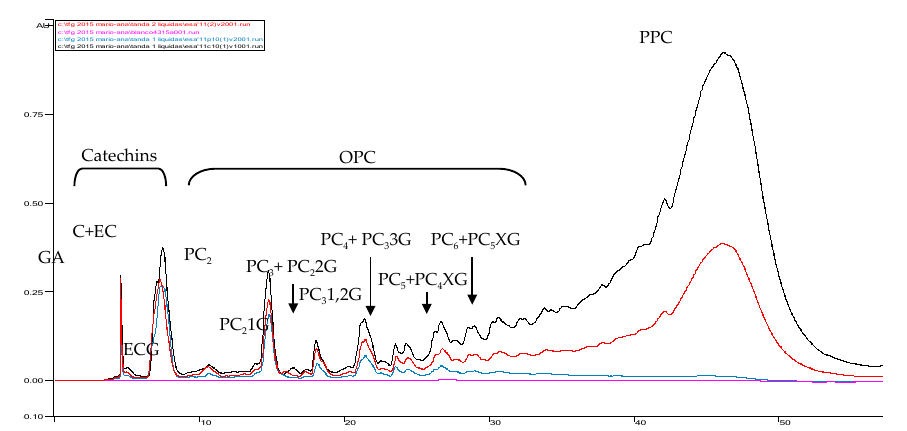
Figure 4. Overlay of NP–HPLC–PAD chromatograms (280 nm) of the initial (clarified) grape seed extract (GSE; red), the final permeate (blue), the final concentrate (black) and the HPLC baseline (violet) after GSE fractionation by a 10-kDa MMCO membrane (data refer to one replicate). GA—gallic acid, C + EC—catechin and epicatechin, ECG—epicatechin gallate, PC 2 to PC 6 —procyanidin dimers to hexamers, PC 2 1G—monogaloylated procyanidin dimer, PC 2 2G—digaloylated procyanidin dimer, PC 3 1,2G—mono- and digaloylated procyanidin trimers, PC 3 3G—trigaloylated procyanidin trimer, PC 4 XG and PC 5 XG—multigaloylated procyanidin tetramers and pentamers, OPC—oligomeric procyanidins, PPC—polymeric procyanidins.